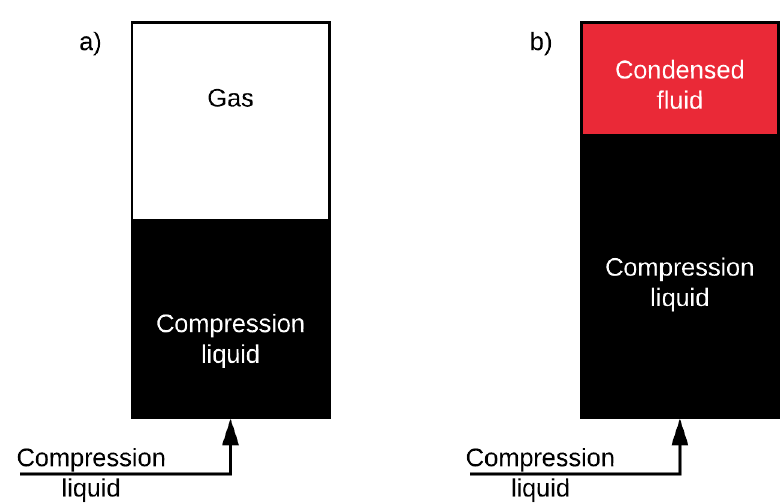
Figure 3. Within the same pressure limits, a non-condensable gas system ( a ) will utilize less compression liquid volume than a system with condensable gas ( b ).